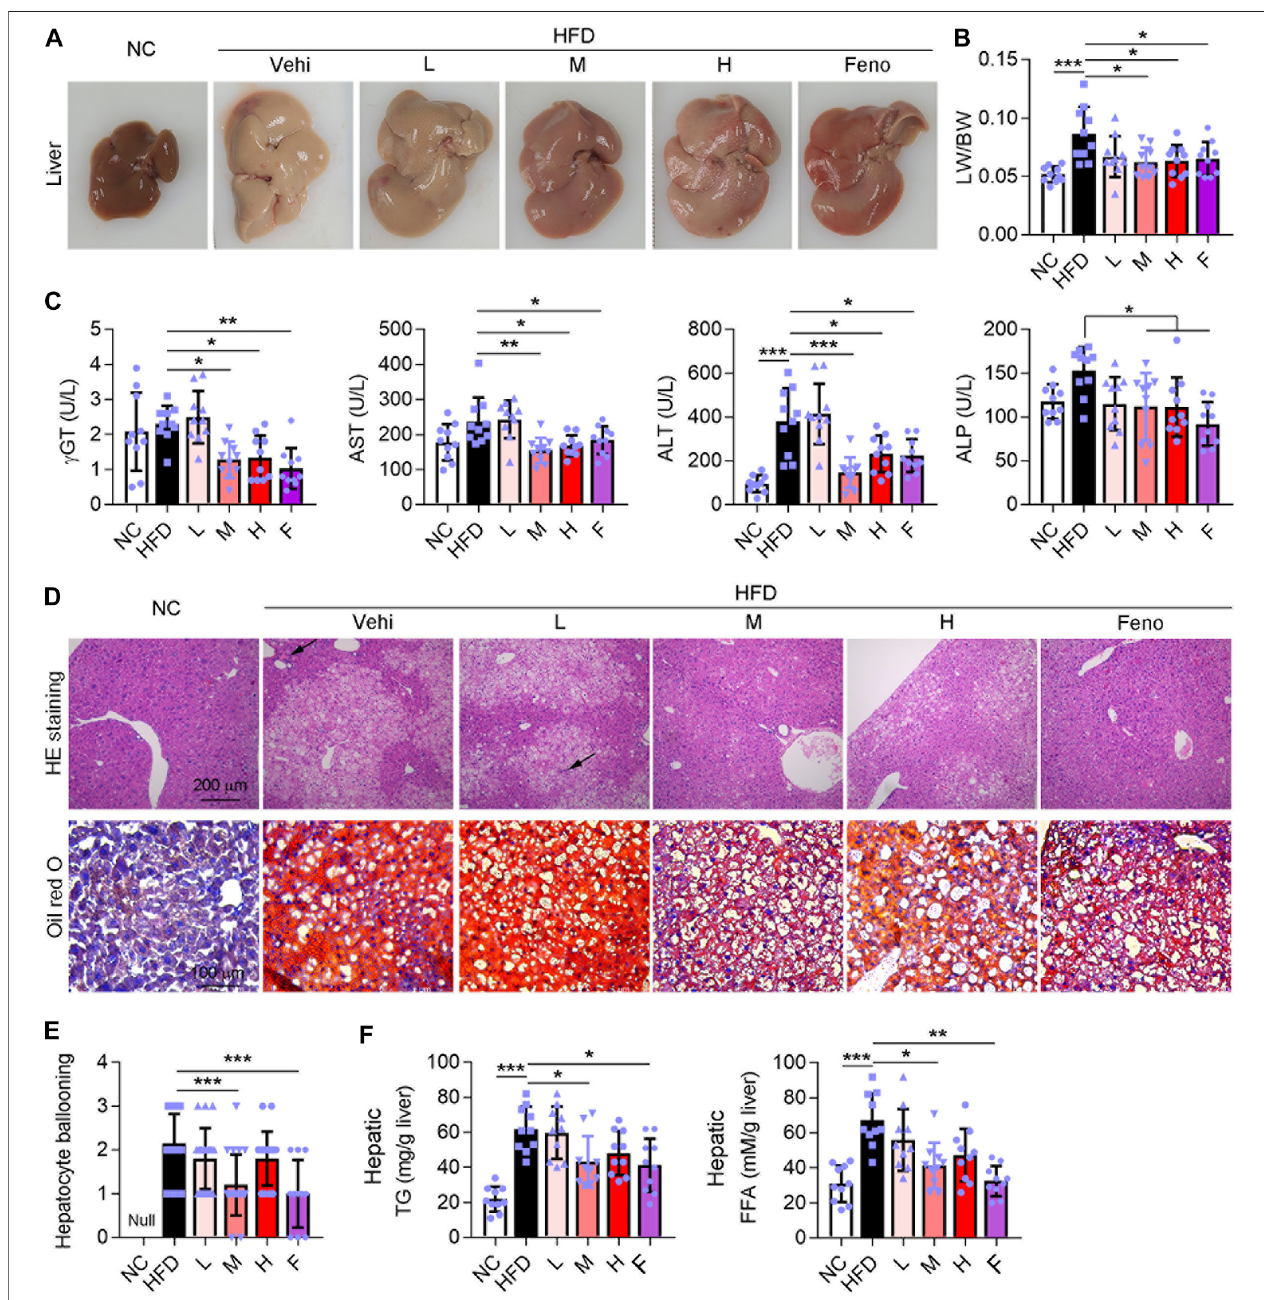
FIGURE 1 | Ganweikang tablet alleviates liver lesions in HFD-induced NAFL mice. (A) Representative images of mouse liver. (B) The ratio of liver weight (LW) to body weight (BW) in mice with different treatments as indicated in the fi gure, n = 10. (C) Serum γ GT, AST, ALT, and ALP were detected using kits, n = 10. (D) RepresentativeimagesofHEstaining(uppanel)andoilredOstaining(downpanel)ofmouseliver. (E) Hepatocyteballooningofmiceliver, n =10. (F) HepaticTGandFFA content were determined by kit, n = 10. * p < 0.05, ** p < 0.01, *** p < 0.001, by one-way ANOVA with Bonferroni correction.